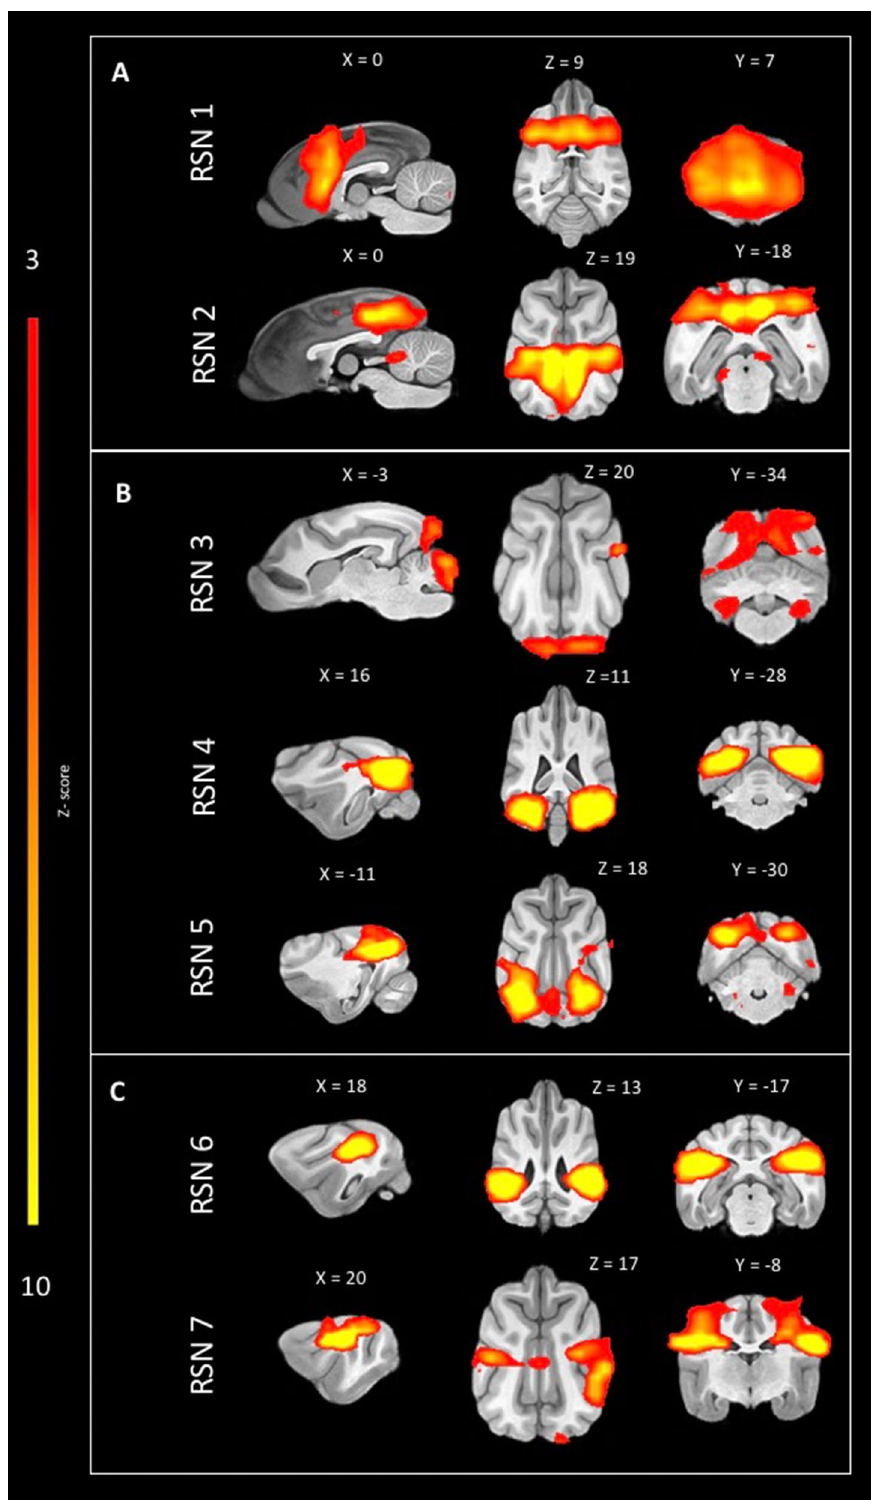
Figure 1. Sagittal, dorsal and transversal images of RSN obtained by means of group ICA of the healthy control dogs only and overlaid on a T1W open-source stereotactic atlas 46 . The results are reported as local false discovery rate controlled (p < 0.05) thresholded z-maps, with red-yellow color encoding using a 3 < Z-score threshold. This figure was created using FSLeyes (version 2.1 https:// fsl. fmrib. ox. ac. uk/ fsl/ fslwi ki/ FSLey es) and Microsoft Powerpoint (version 16.16.19, http:// www. micro soft.